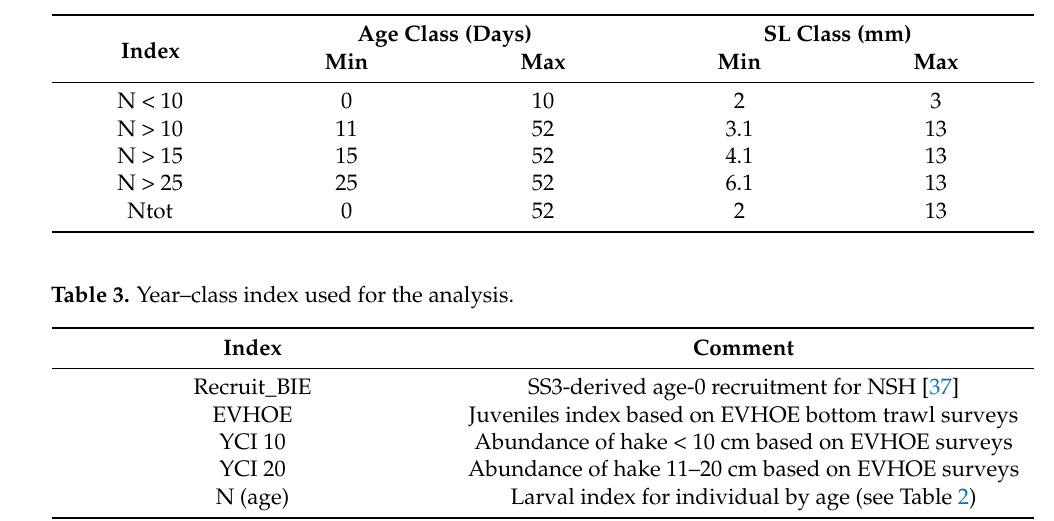
Table 2. Larvae abundance index used in the analysis.